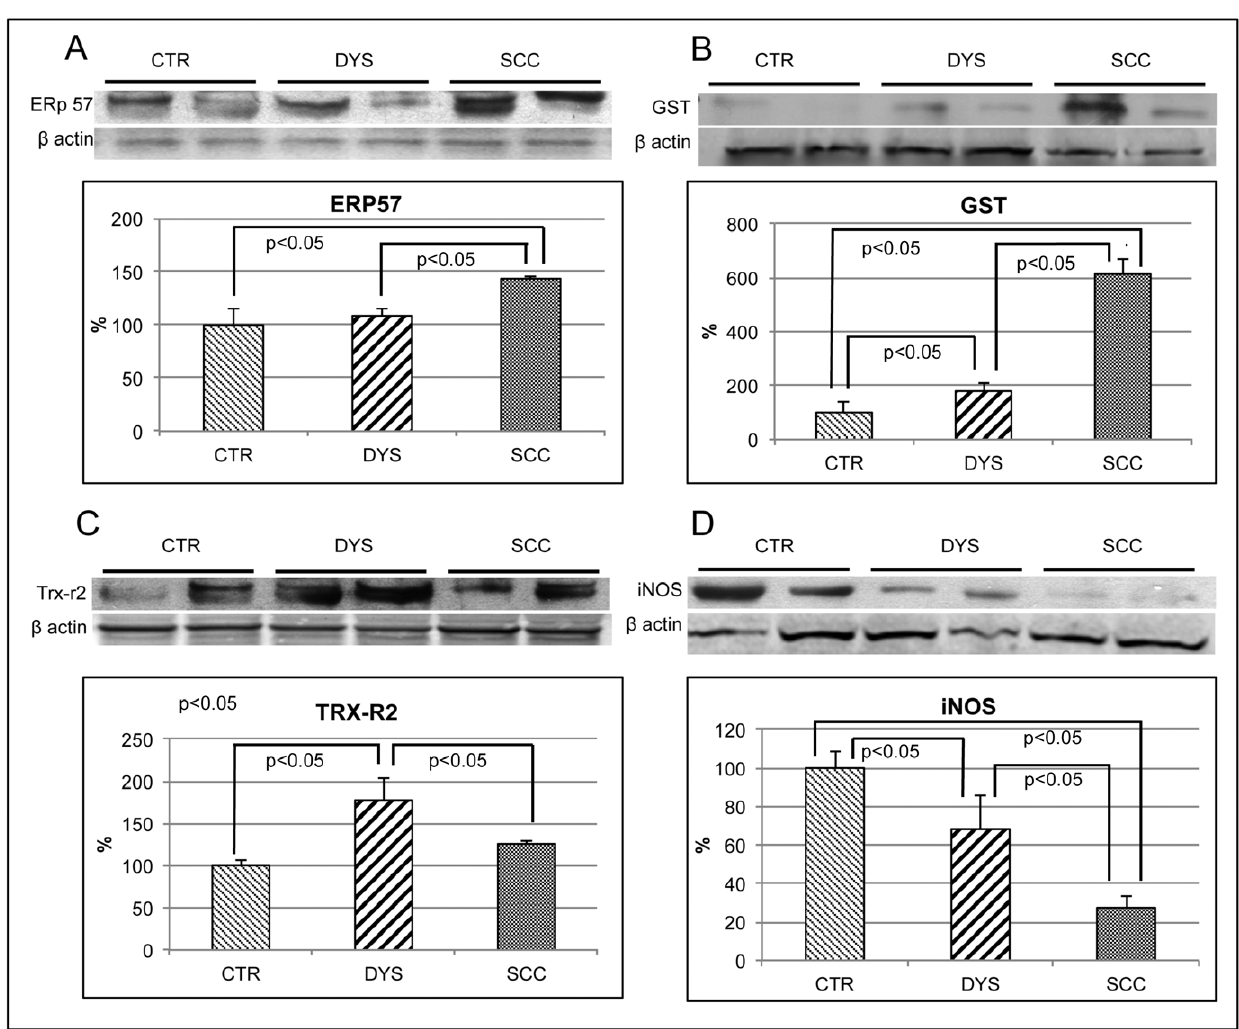
Figure 2. Expression levels of stress markers (ERp57, GST, TRX-R2 and iNOS). Protein expression levels in CTR, DYS and SCC cervical tissues were measured by Western blot analysis using specific antibodies for ERp57 (A), GST (B), TRX-R2 (C) and iNOS (D). Immunoblots were scanned by densitometry and all values were normalized to b -actin levels. Densitometric values shown are given as percentage of the control group, set as 100%. Data are expressed as mean 6 SEM. p , 0.05 versus control (Student’s t -test).